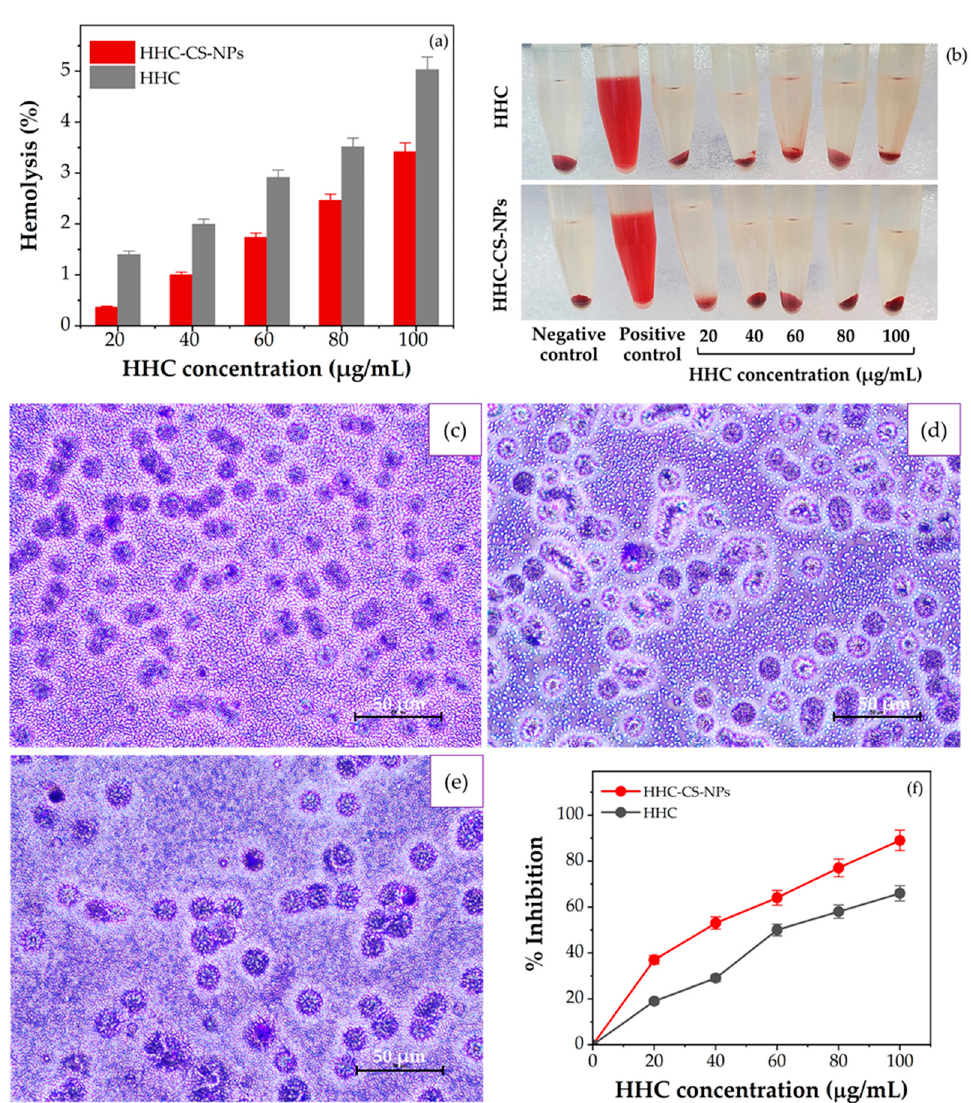
Figure 7. In vitro inflammatory activity assessed by ( a ) hemolysis percentage in Wistar rat erythro ‐ cytes following 2 h incubation with HHC or HHC ‐ CS ‐ NP samples with different concentrations of HHC at 37 °C ( n = 3). ( b ) Image of samples with different concentrations of HHC after centrifugation at 3500 rpm for 5 min: PBS and ultrapure water were negative ( − ) and positive (+) controls, respec ‐ tively. The presence of large amounts of hemoglobin in the supernatant is only observed in the pos ‐ itive control; ( c – e ) Giemsa staining of Wistar rat erythrocyte smears of ( c ) negative control (PBS), ( d ) HHC, and ( e ) HHC ‐ CS ‐ NPs at the equivalent of 100 μ g/mL of HHC concentration. The magnifica ‐ tion was ×40. ( f ) Effect of HHC and HHC ‐ CS ‐ NPs on protein denaturation ( n = 3 ).